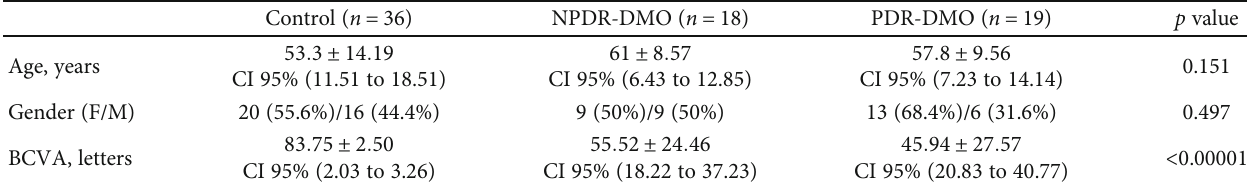
Table 1: Baseline characteristics of the patients included in the study.